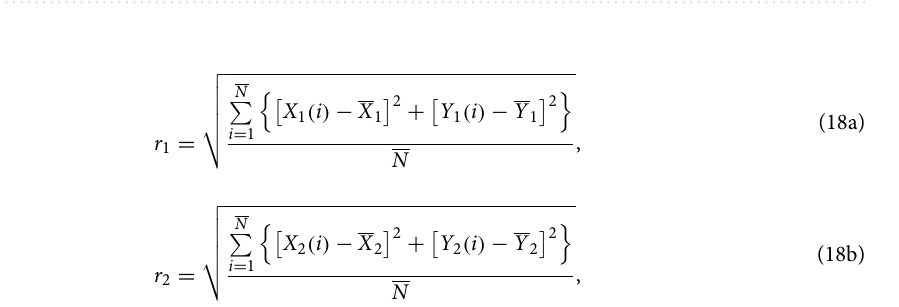
Figure 6. Model of inter-shaft bearing’s